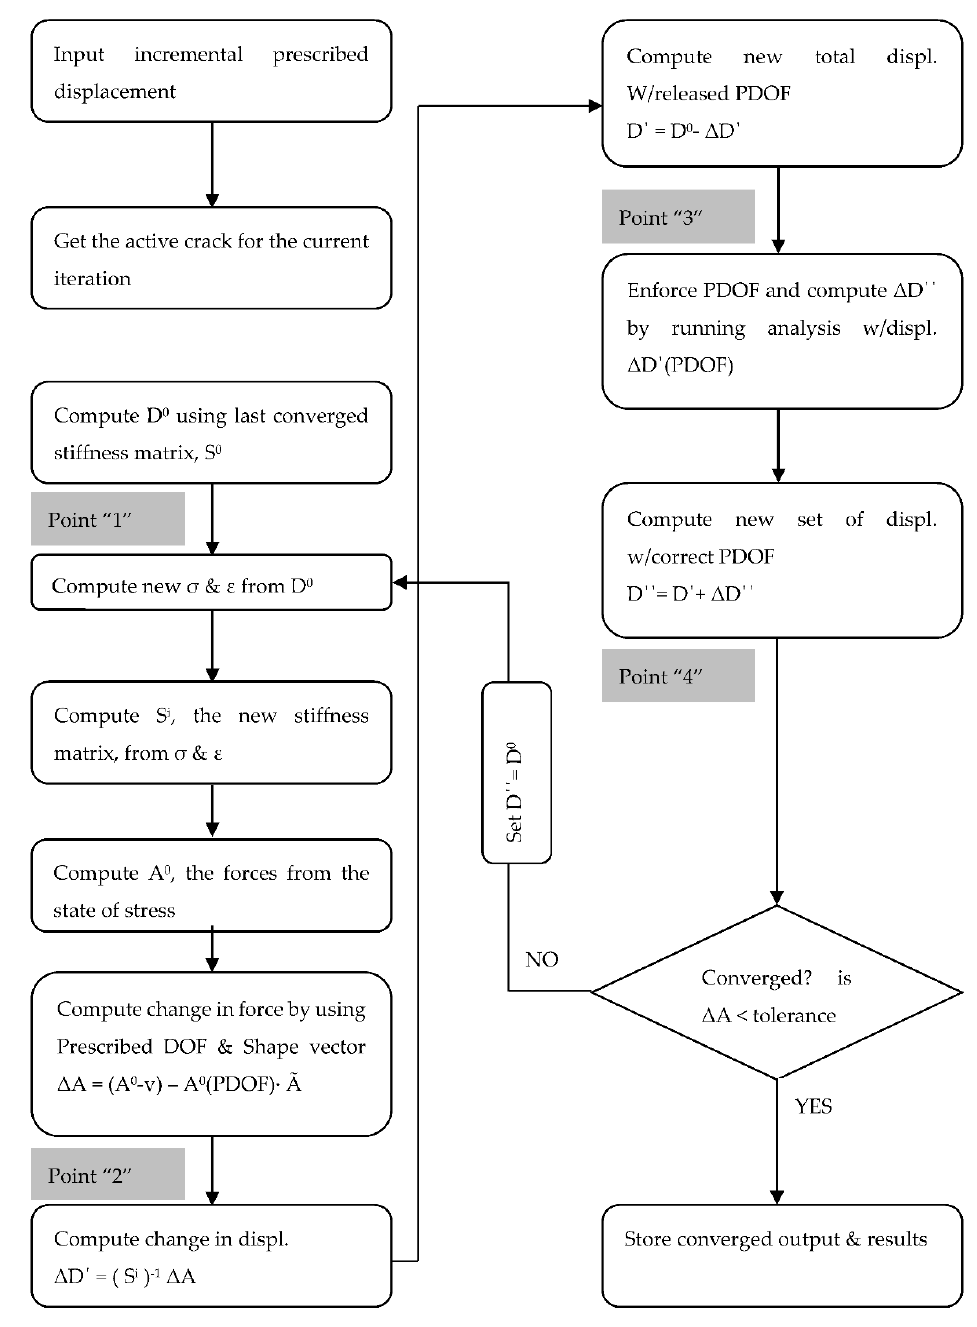
Figure 11. Flowchart of the modified Newton–Raphson algorithm.